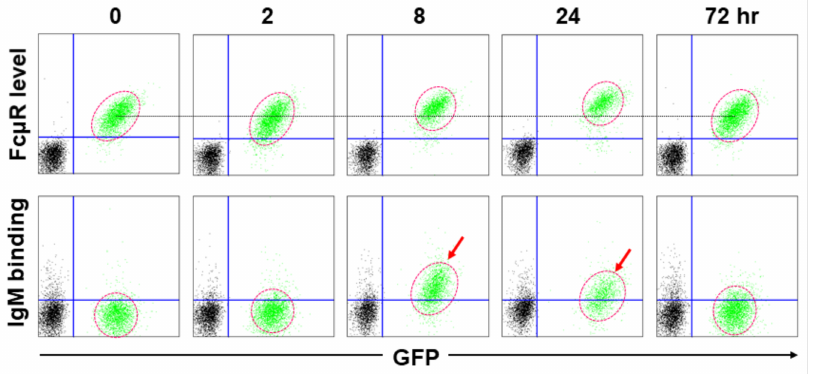
Figure 2. Transient IgM binding by mouse Fc µ R-bearing transductant. AKR-derived thymoma line BW5147 cells stably expressing mouse Fc µ R and GFP (green) and WT BW5147 cells (black) were plated at 5 × 10 4 cells/mL, cultured at 37 ◦ C, and harvested after the indicated time periods. An equal mixture of Fc µ R + /GFP + cells and WT cells was incubated with mouse IgG1 κ mAb specific for mouse Fc µ R (MM3 clone; upper panel) or mouse IgM κ paraprotein (TEPC183; lower panel), washed, and developed by PE-labeled, rat IgG1 κ anti-mouse κ mAb (187.1 clone) to determine the Fc µ R level and IgM binding, respectively. Stained cells were analyzed by flow cytometry. Note the IgM binding by Fc µ R + /GFP + cells at early stages of culture (see arrows) compared to the minimal changes in cell surface receptor levels. GFP + cells are circled with red dotted lines and a black line corresponds with mean fluorescence intensity of PE of Fc µ R + /GFP + cells at 0 h for